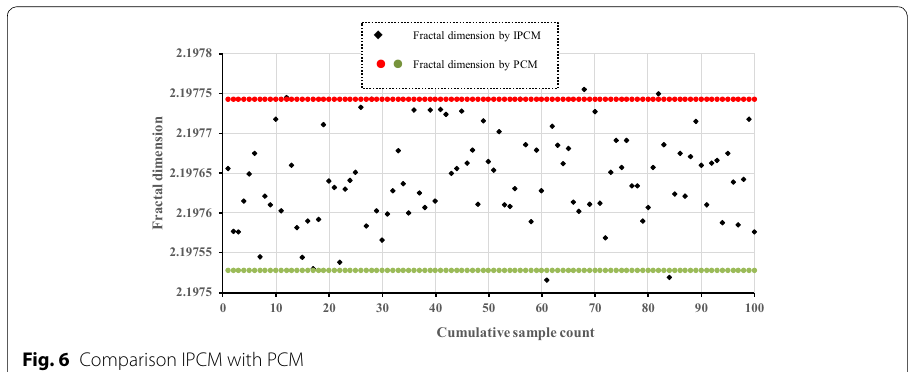
Fig. 6 Comparison IPCM with PCM